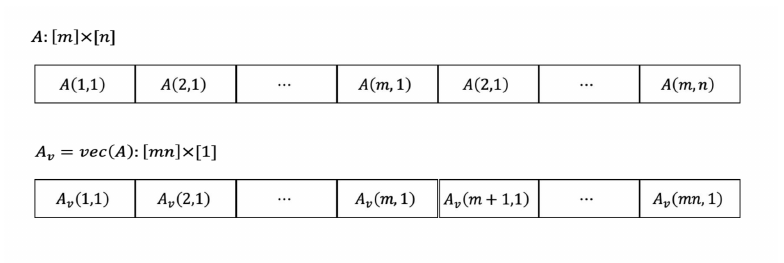
Figure 2. Vectorizing a matrix A into vec( A ) in